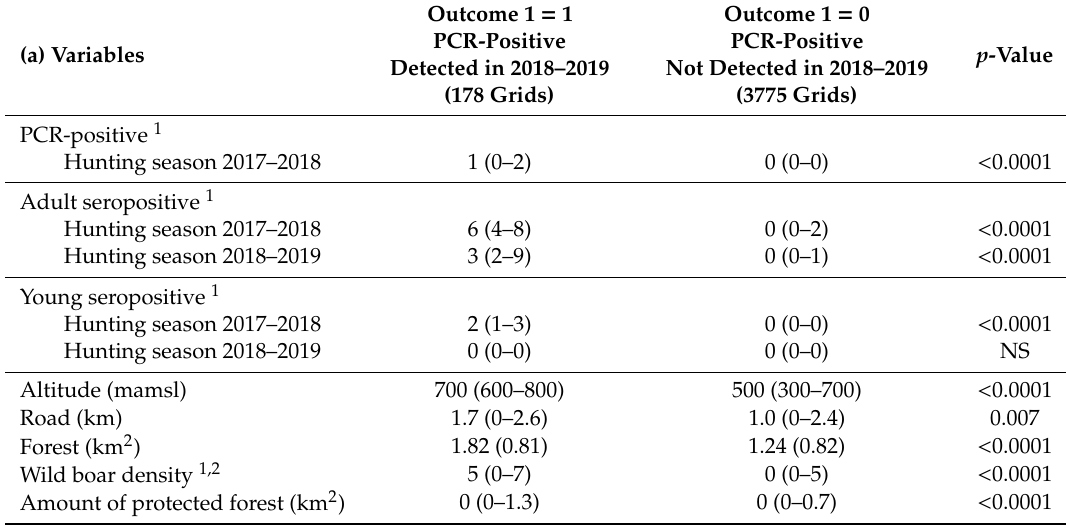
Figure 3. African swine fever PCR-positive animals detected in 2018–2019 (outcome 2—red dots) and seropositive young animals in 2019–2020 (outcome 2—blue dots) in the two areas of Goceano–Baronia and Barbagia–Ogliastra (bold black lines). Points around the red and blue dots identify that the neighboring grids were positive values were imputed, considering the 5 km 2 for the radius. Table 2. Descriptive statistics of variables in the training dataset (Goceano–Baronia) for (a) outcome 1 (PCR-positive wild boar detected in 2018–2019) and (b) for outcome 2 (young seropositive animals detected in 2019–2020). Data are presented as the frequency (%) or mean (standard deviation (SD)), median (I–III interquartile), and p -value.